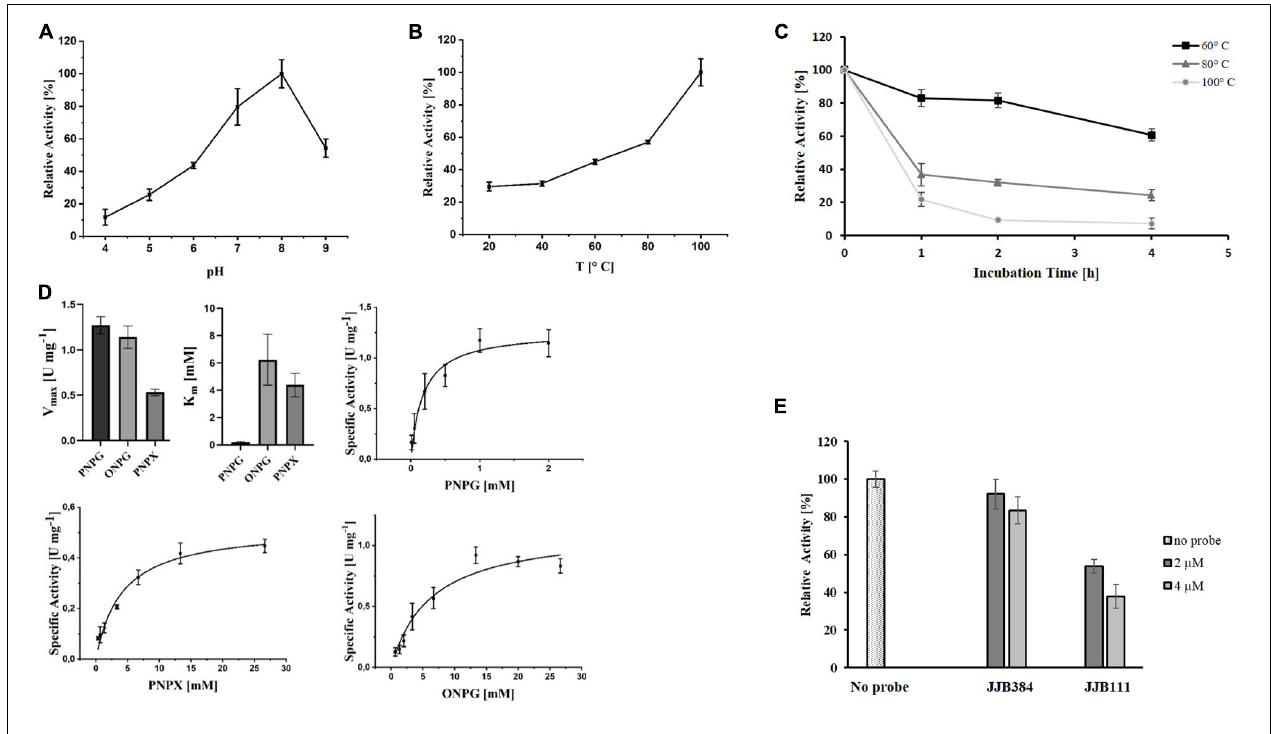
FIGURE 8 | Characterization of heterologously expressed EGIDFPOO_00532. Effect of pH (A) and temperature (B) on the β -xylosidase activity of EGIDFPOO_00532. (C) Thermostability of EGIDFPOO_00532. The residual β -xylosidase activity of EGIDFPOO_00532 after preincubation at 60 ◦ C (black line, (cid:4) ), 80 ◦ C (dark gray line, (cid:78) ) or 100 ◦ C (bright gray line, ) for up to 4 h was determined. (D) Kinetics characterization of EGIDFPOO_00532 with the nitrophenyl substrates PNPG, ONPG and PNPX (pH 8.0, 100 ◦ C). (E) Inhibition of β -xylosidase activity of EGIDFPOO_00532 with 2 or 4 µ M JJB384 and JJB111, (cid:32)